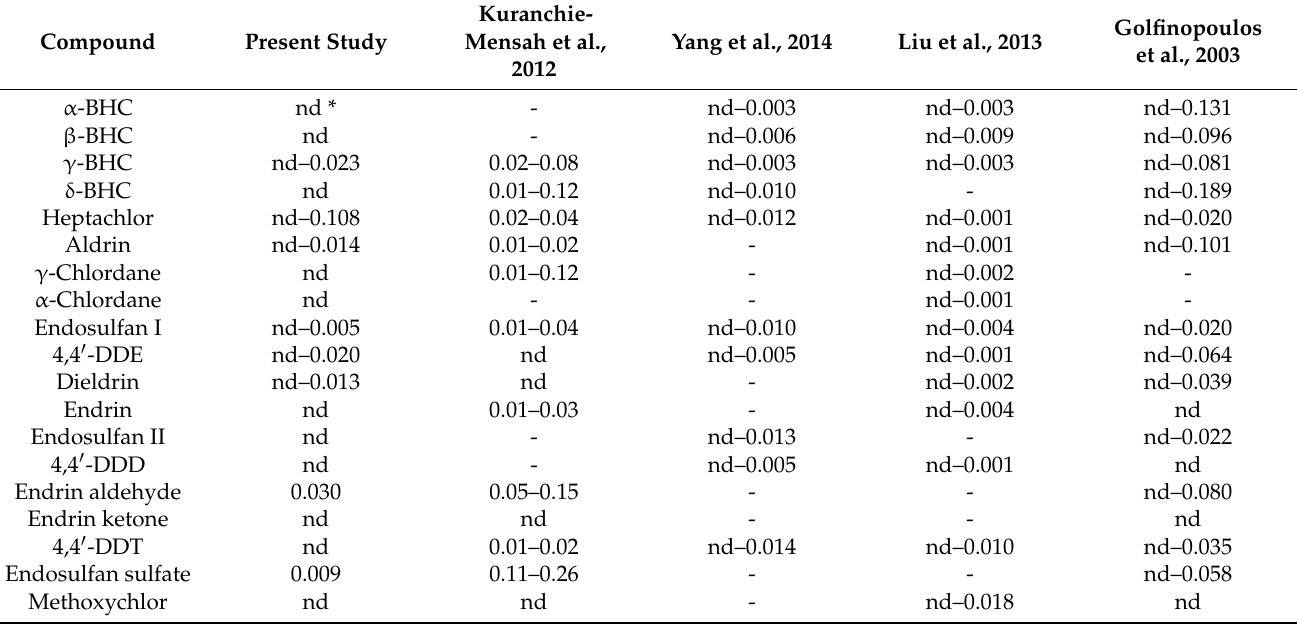
Table 5. Comparison of pesticide contamination concentrations ( µ g L − 1 ) with the reported